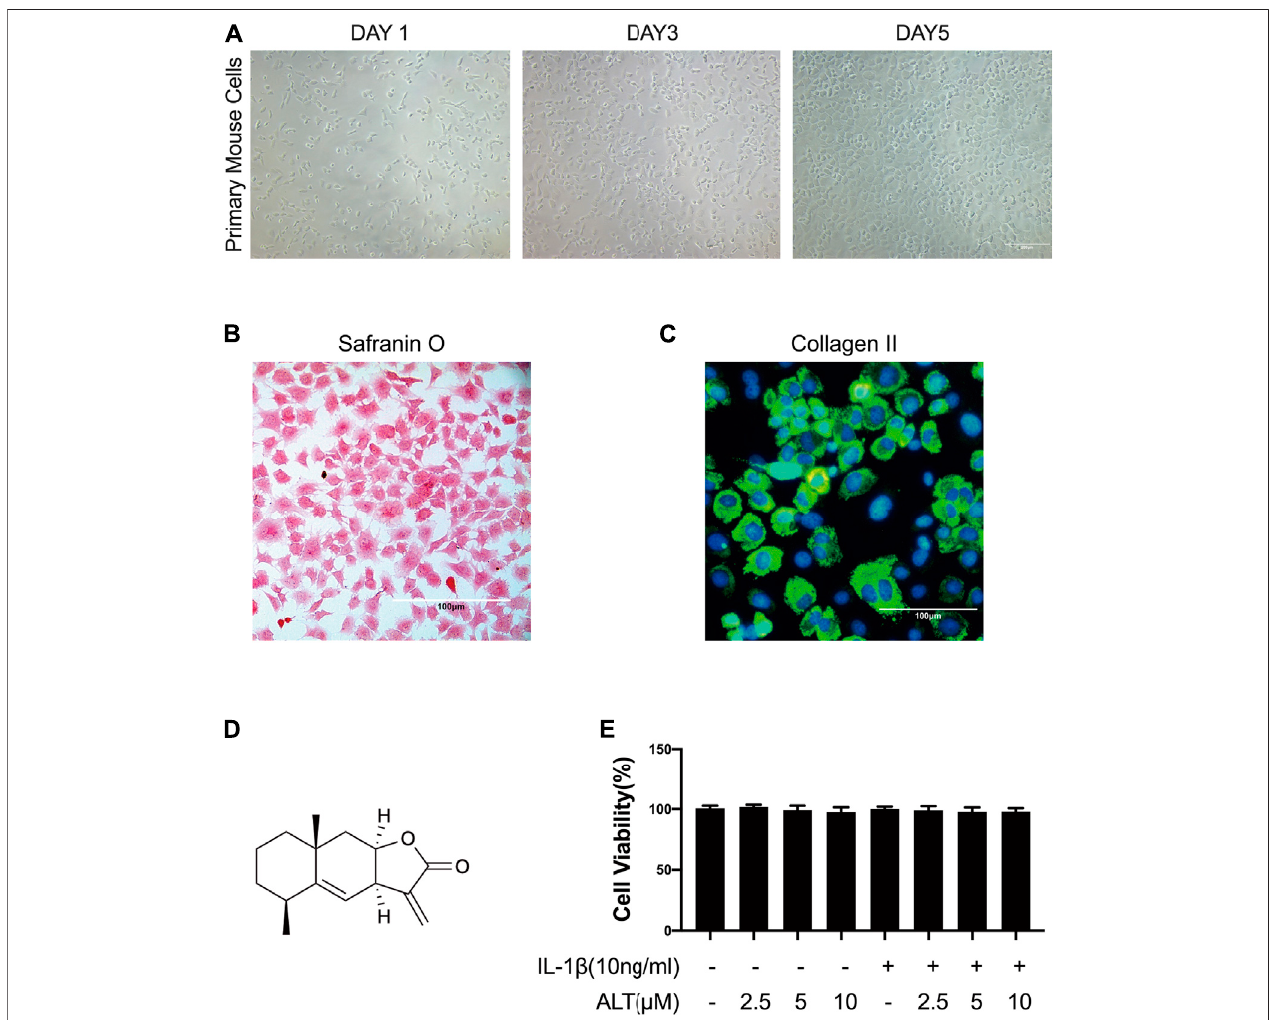
FIGURE 1 | The identi fi cation of mouse chondrocytes and ALT did not impact the viability of mouse chondrocytes. (A) Phase-contrast micrographs of primary mouse cellsafterisolationday1,3,and 5. (B) SafraninOstainingofprimary mousecells. (C) CollagenIIimmuno fl uorescence stainingofprimary mousecells. Cellswere treated by ALT (2.5, 5, and 10 μ M) in the presence or absence of IL-1 β (10 ng/ml) for 24 h. (D) Chemical structure of ALT. (E) Cell viability was determined by CCK-8 assay.